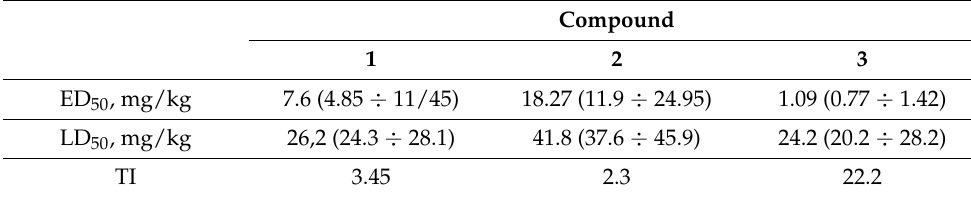
Table 5. Main indicators of the effectiveness of drugs evaluated in the model of staphylococcal sepsis in